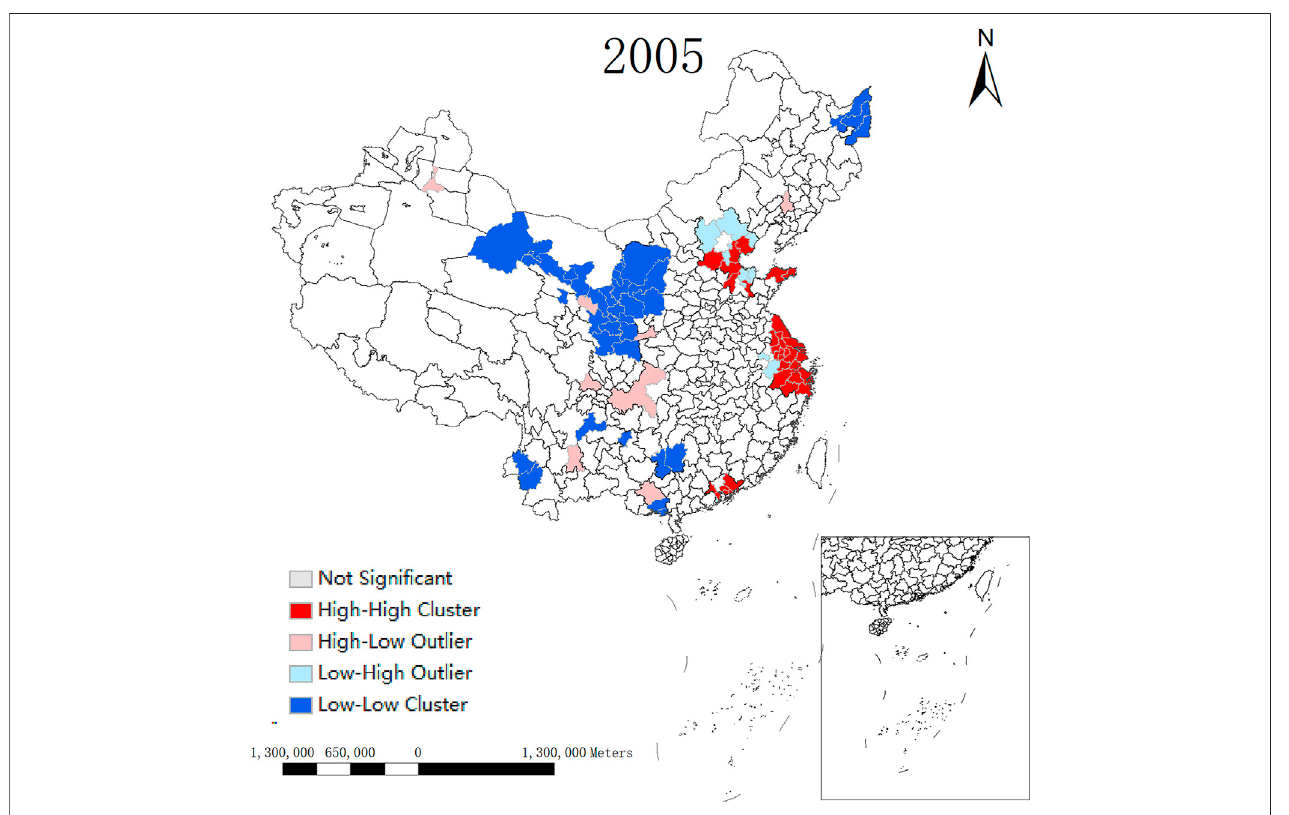
FIGURE 2 | Spatial correlation distribution of urban consumption in